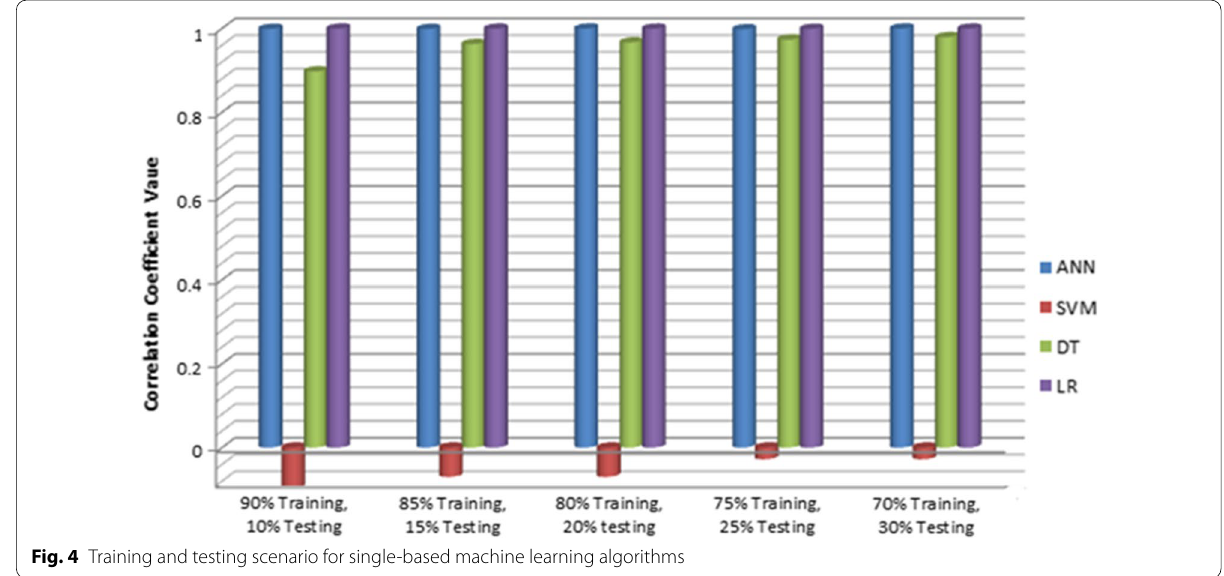
Fig. 4 Training and testing scenario for single-based machine learning algorithms